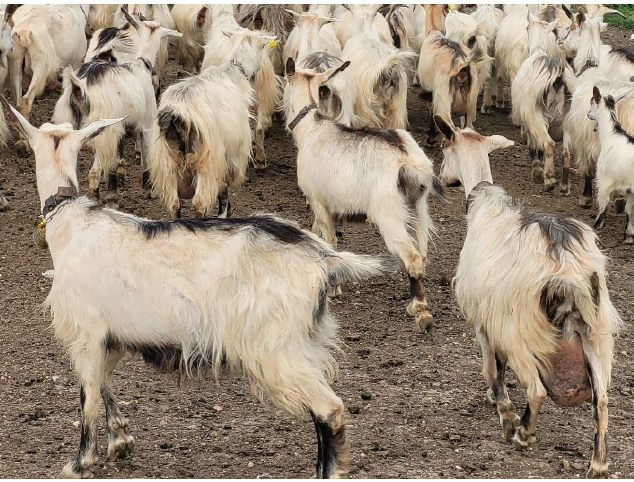
Figure 1. Mascaruna goats.